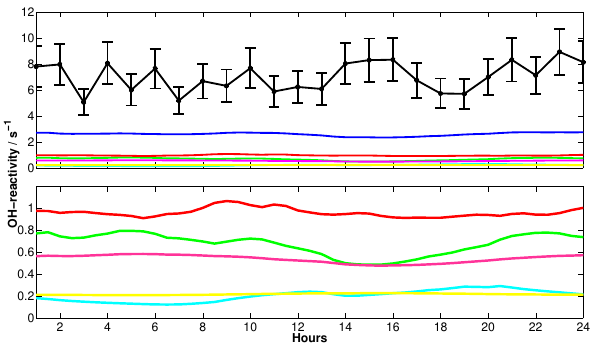
Fig. 4. Top figure: Measured (black) and modelled (dark blue) OH- reactivity including contributions from inorganic compounds (red), isoprene (light blue), monoterpenes (green), methane (yellow) and other organic compounds (pink). Bottom figure: Zoom of the con- tributions to the OH-reactivity. The color code is the same as in the top figure. In both figures the OH-reactivity is given as daily average for Period A.